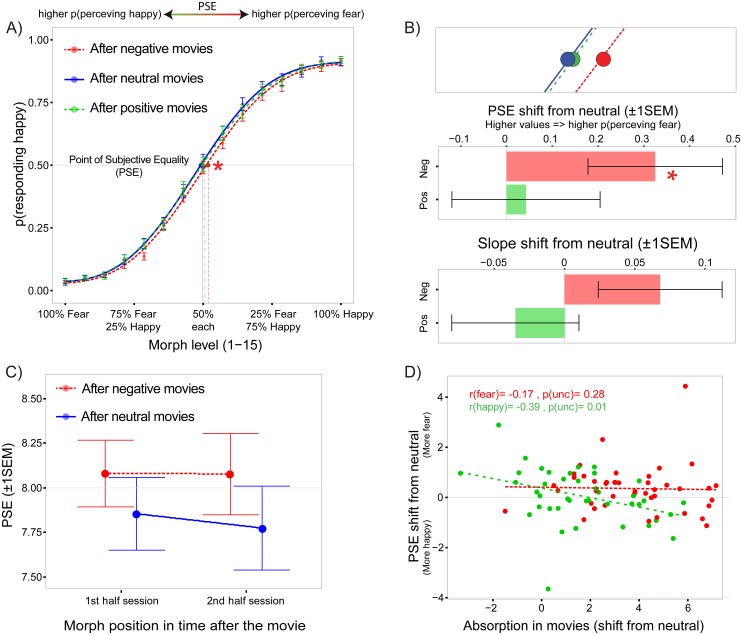
Interpretation bias following transient emotion induction.A) Sigmoid curves illustrating the probability of categorizing morphed faces as expressing happiness across morph levels and emotional contexts. Curve fitting resulted in two parameters for each subjects and each emotional context: the point of subjective equality (PSE), which characterizes the morph level at which the subject is at chance for discriminating happy vs. fearful expressions (also termed interpretation bias), and the slope of the curve at the PSE, which characterizes the sharpness of the decision boundary between happy and fearful faces. B) Top plot: zoom on the group average PSE for each emotional context. Middle plot: After viewing negative movies relative to neutral clips (red), participants increased their propensity to classify ambiguous expressions as fearful. No significant average shift (relative to neutral) was observed after watching positive movies (green). Bottom plot: There was an increase in slope after negative compared to neutral movies. C) Evolution of the bias over time in the negative context revealed that it persisted during the entire decision-making task (~2 minutes). Error represent ±1SEM. D) Correlations between absorption ratings and PSE shifts (for emotional compared to neutral movies) showed that for the positive context, more absorbing movies led to increased propensity to classify ambiguous faces as happy. Note that all statistical tests remained significant after removing two potential outliers with the most positive and the most negative PSE shifts.